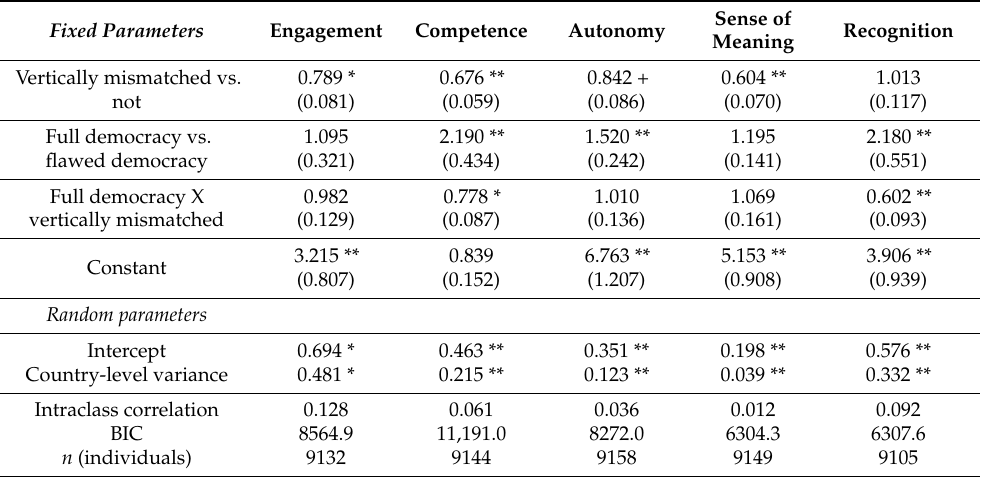
Table 4. Influence of vertical mismatch on different aspects of subjective well-being and cross-level interactions between vertical mismatch and democracy regime, odds ratios (standard errors in